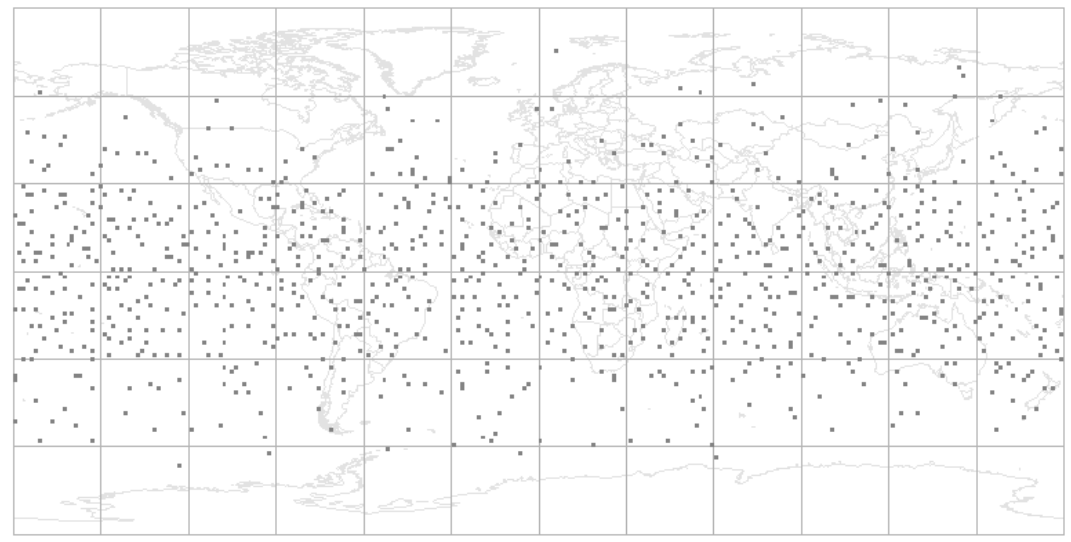
Figure 2. The first 1000 points of the Global Grid at level 7 ( GG 7 ), adjusted for global use.